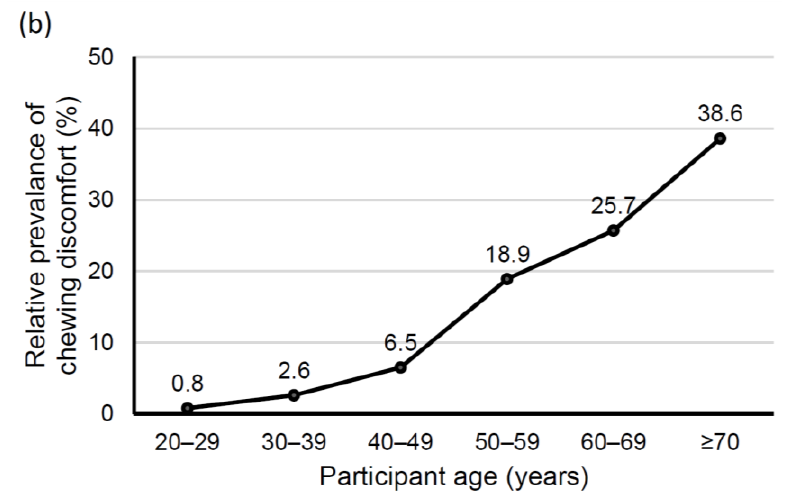
Figure 1. Chewing discomfort according to age classes. ( a ) Percentage of participants with chewing discomfort ( p for trend < 0.0001). ( b ) Relative prevalence of chewing discomfort for dental prosthesis users ( p for trend < 0.0001). Table 2 shows the distributions of participants depending on the type of dental pros- thesis used. Our findings showed that age, gender, income, education, residence, BMI, obesity, current smoking, alcohol consumption, stress, diabetes, hypertension, dental pain, dental clinic visit during the previous year, number of remaining teeth, and the daily frequency of tooth brushing differed significantly according to the distributions with the type of dental prosthesis ( p < 0.05). Table 2. Distributions of participants according to the dental prosthesis used. Without Fixed Partial Complete p -Value Prosthesis Prosthesis Denture Denture